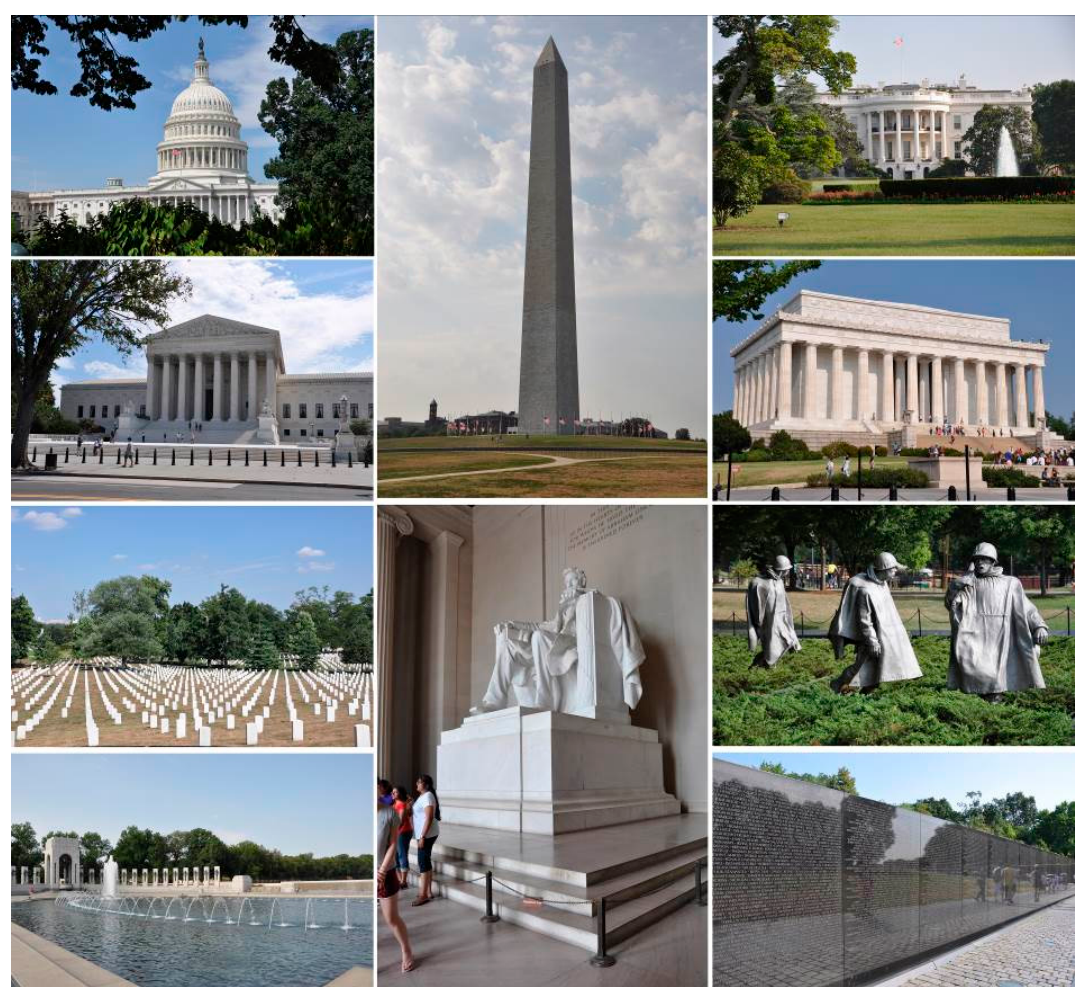
Figure 6. Pictures of some monuments and historic buildings in Washington: the Capitol, the White House, the Supreme Court, Washington, Lincoln, World War II, the War of Korea and Vietnam, the Cemetary of